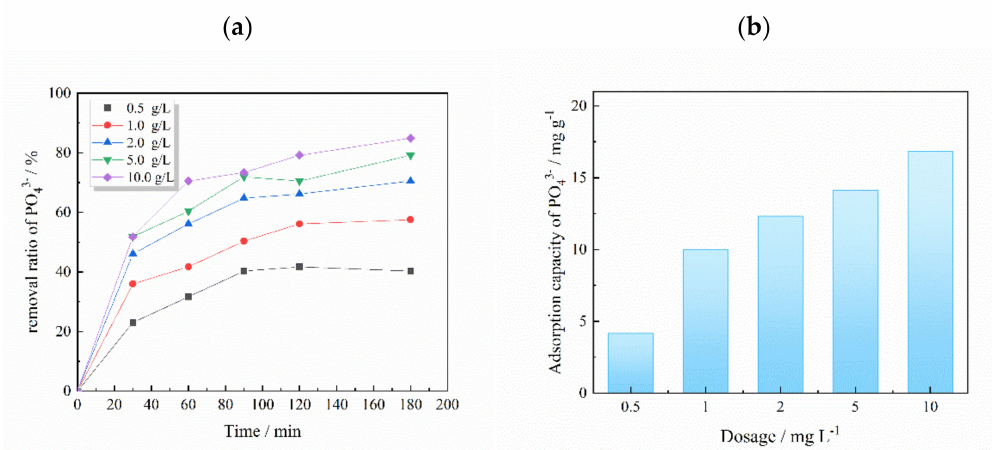
Figure 4. Phosphate removal by the La − CZ adsorbent with different adsorbent dosages. ( a ) the removal ratio of different adsorbent dosages; ( b ) the adsorption capability of different adsorbent dosages). Table 2. ComparisonofphosphorusremovalcapacityofparticulateadsorbentsandsomeLa-basedadsorbents.